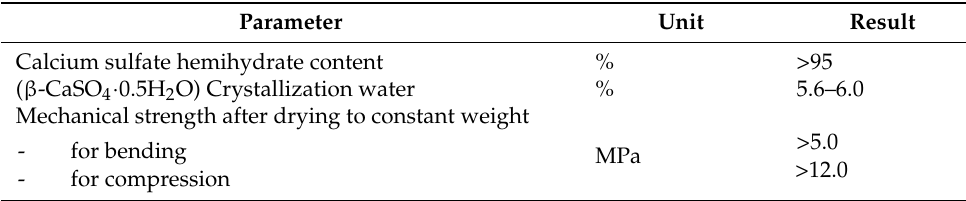
Table 2. Main parameters of Atlas gypsum.